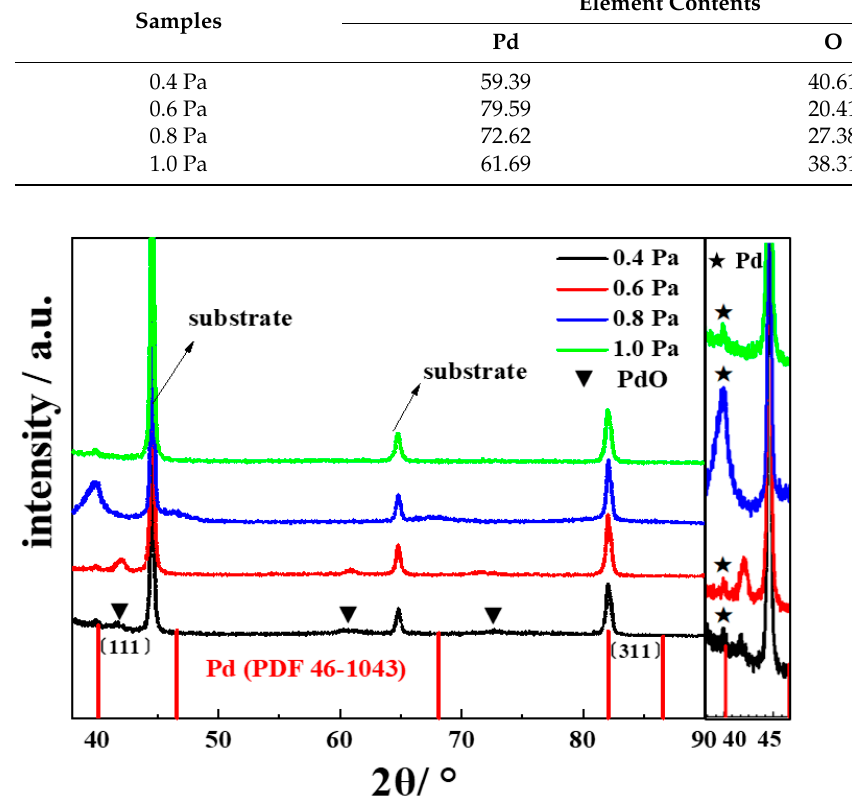
Figure 4. XRD patterns of films deposited at different sputtering pressures.